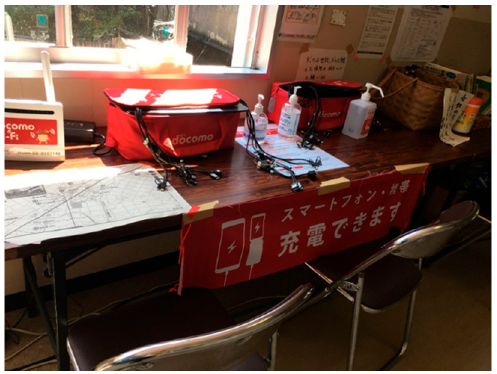
Figure 6. Hand sanitizers at mobile phone charging areas.